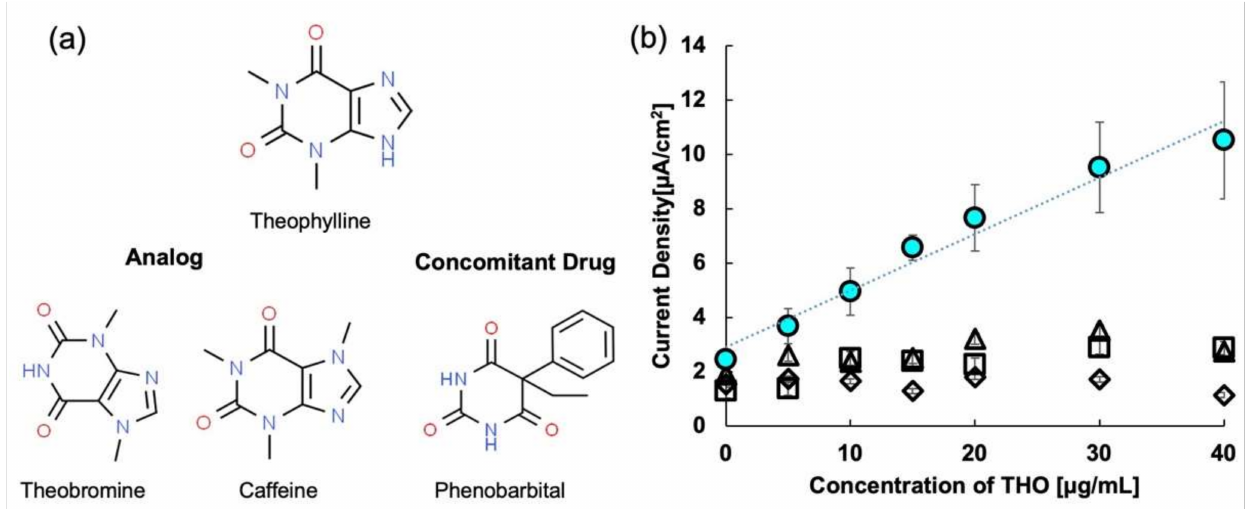
Figure 6. ( a ) Structures of theophylline along with its analogs and concomitant drugs, and ( b ) response of theophylline MIP to analogs and concomitant drugs. Circles represent response to THO. Squares, triangles, and diamonds represent theobromine, caffeine, and phenobarbital, re-